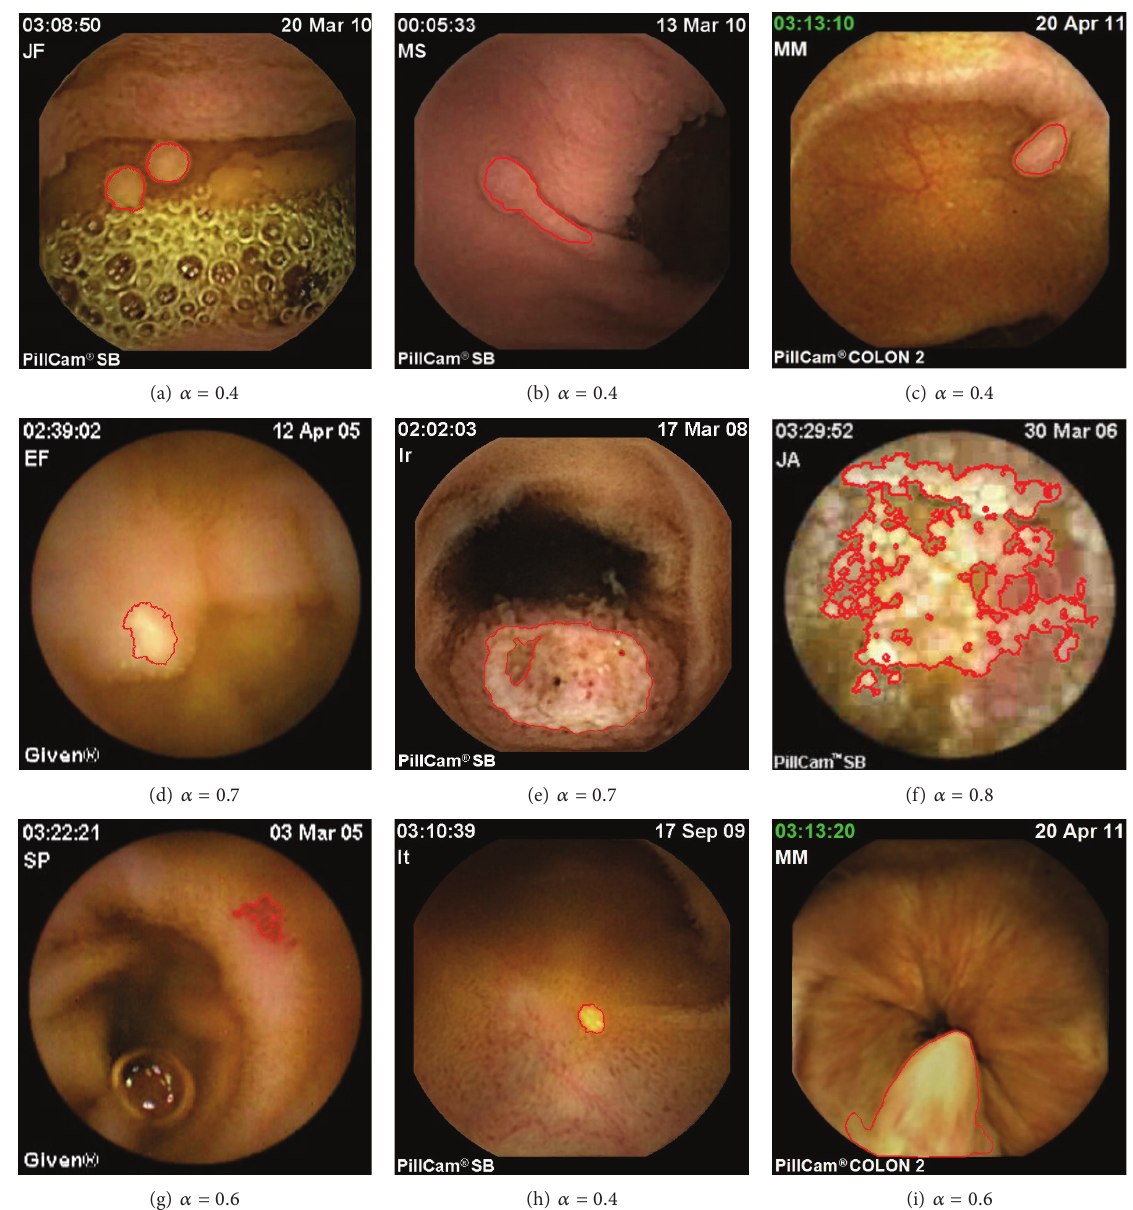
Figure 9: WCE image segmentation using the proposed histogram-based active contour approach. ((a) and (b)) Gastric polyps in Peutz- Jeghers syndrome, (c) colon sigmoid polyp, (d) lymphangiectasia, (e) small-bowel metastasis, (f) radiation enteritis, (g) angiodysplasia, (h) lipoma, and (i) hypertrophied anal papilla. For each segmentation result, indicated values of alpha correspond to the optimal value at convergence of the optimisation